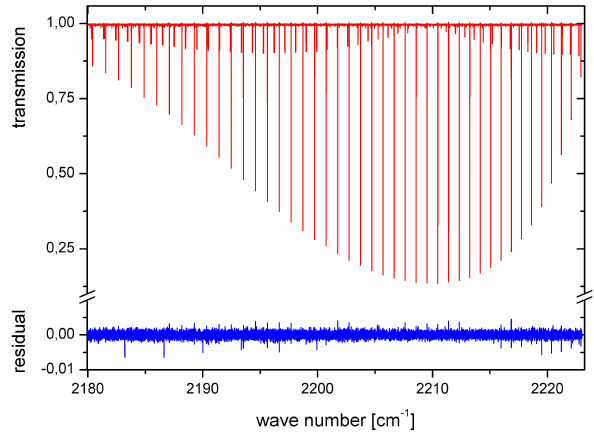
Fig. 10. The spectrum taken with C2 on 26 July 2011 (black), super- imposed the synthetic spectrum fitted by LINEFIT (red) is shown, blue: